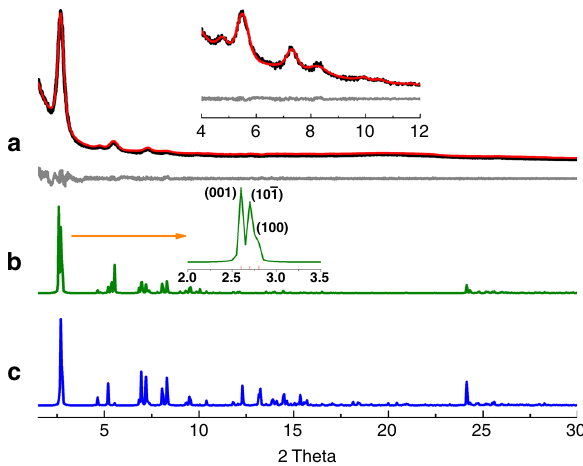
Fig. 2 PXRD pro fi les of Tri-COF-DAB . a Experimental (black) and Pawley re fi ned (red) PXRD patterns and difference plot (gray) between them, b simulated PXRD patterns with AA stacking, and c AB stacking